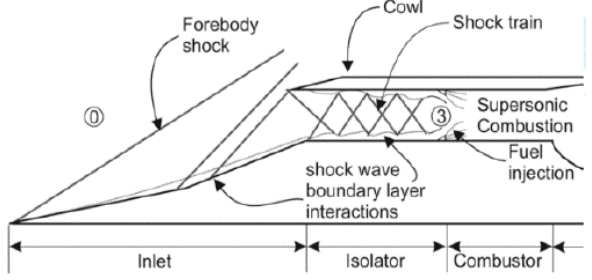
Figure 9. Hypersonic inlet forebody and shock train.